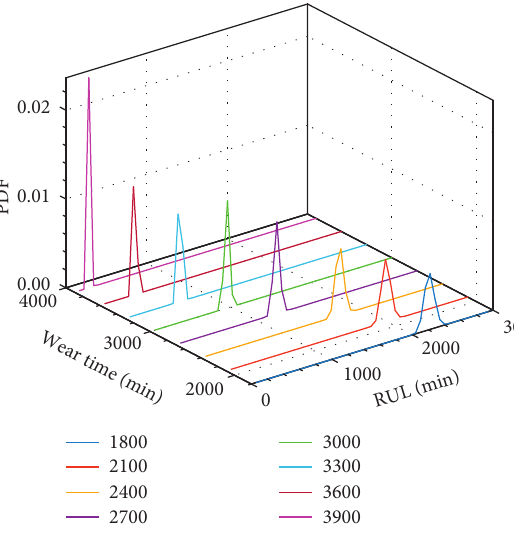
Figure 5: PDF of